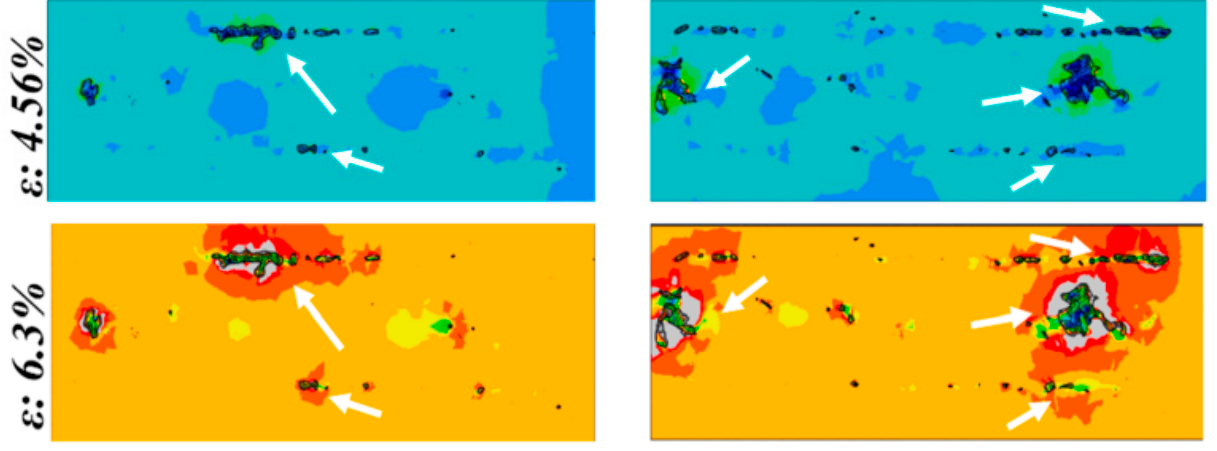
Figure 2. The effects of the pore size and shape on the strain concentration zone “Reused with permission from Elsevier by License No. 5494610474468”